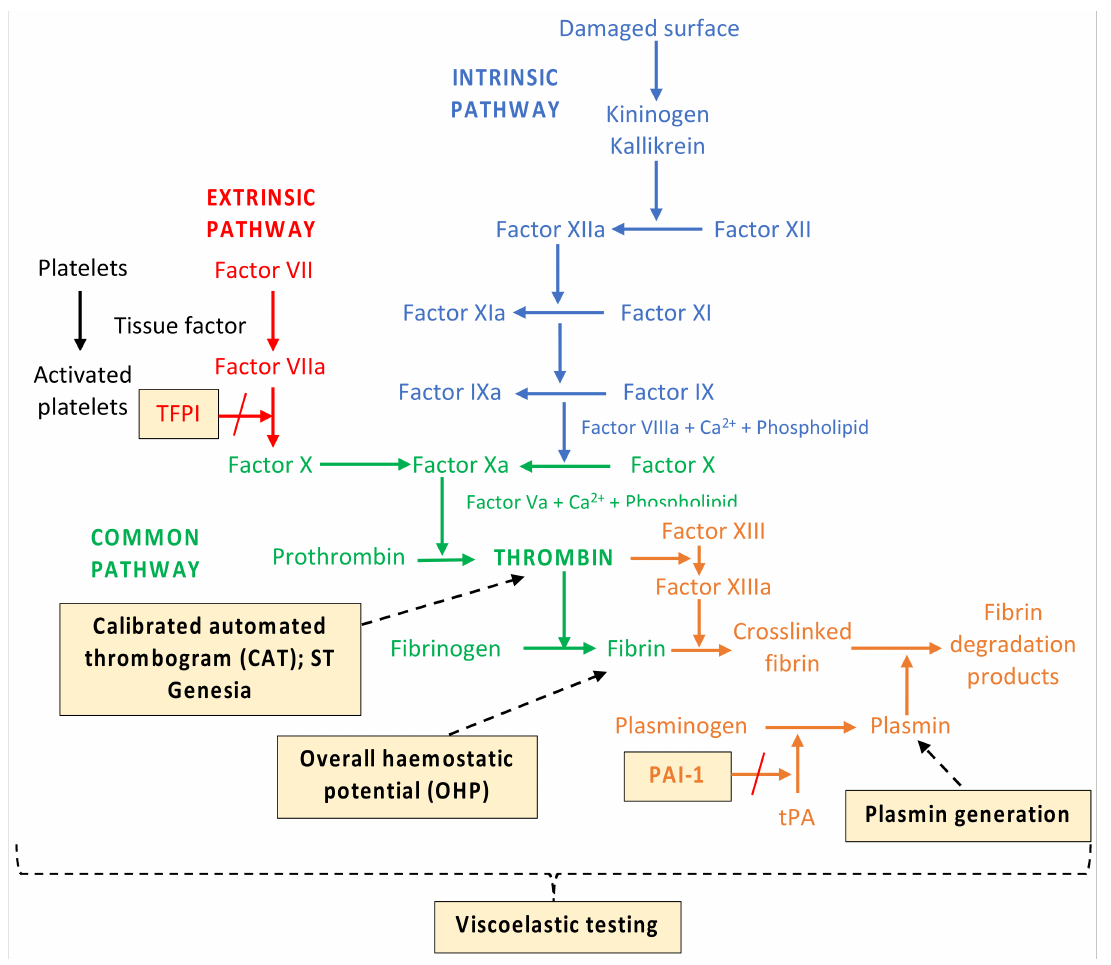
Figure 2. A simplified coagulation cascade highlighting the key pathways examined by some of the available global coagulation assays (highlighted boxes) (Abbreviations: TFPI tissue factor